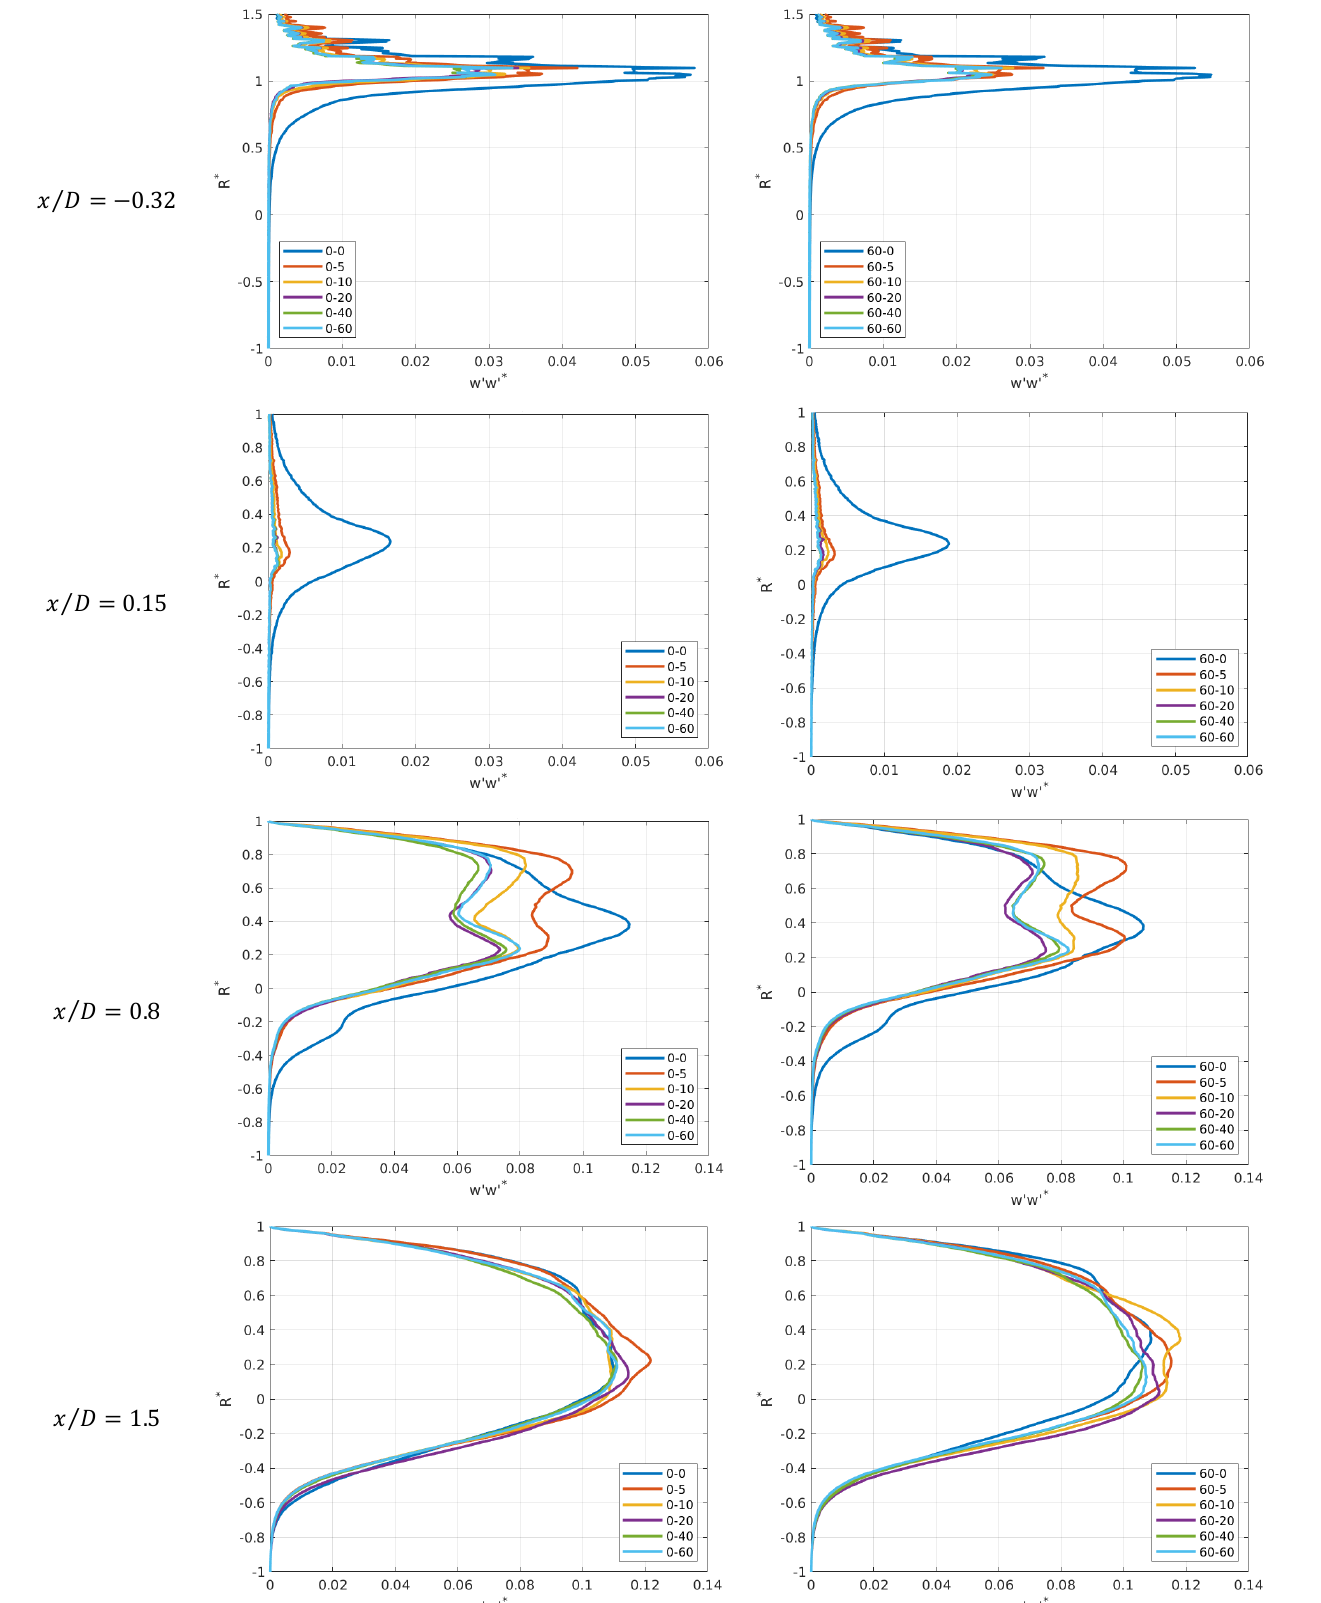
Figure 12. Vertical profiles of 𝑤 (cid:4593) 𝑤 (cid:4593)∗ at different cross-sections.